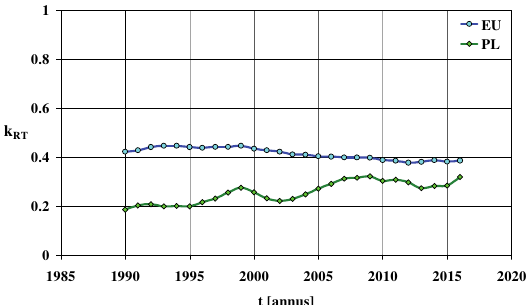
Fig. 15. Share of annual emission from motor vehicles comparing to the total annual emission for nitrogen oxides: in Poland – PL and in the